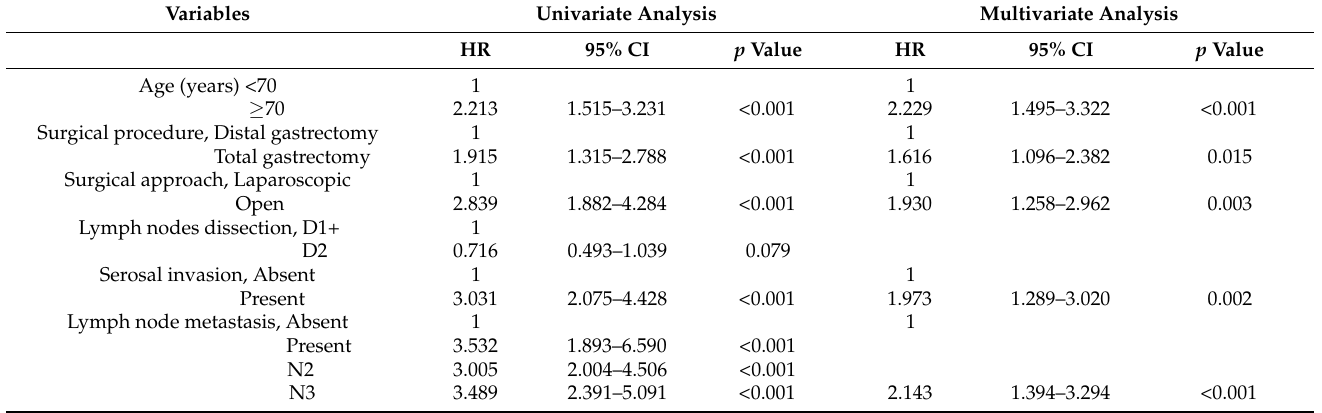
Table 2. Results of univariate and multivariate analyses of prognostic factors for overall survival in men.